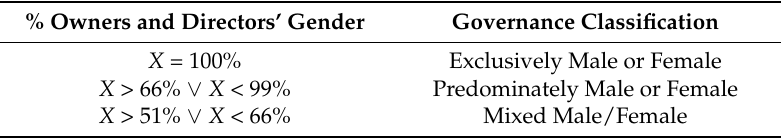
Table A2. Italian innovative startups. Classification by gender